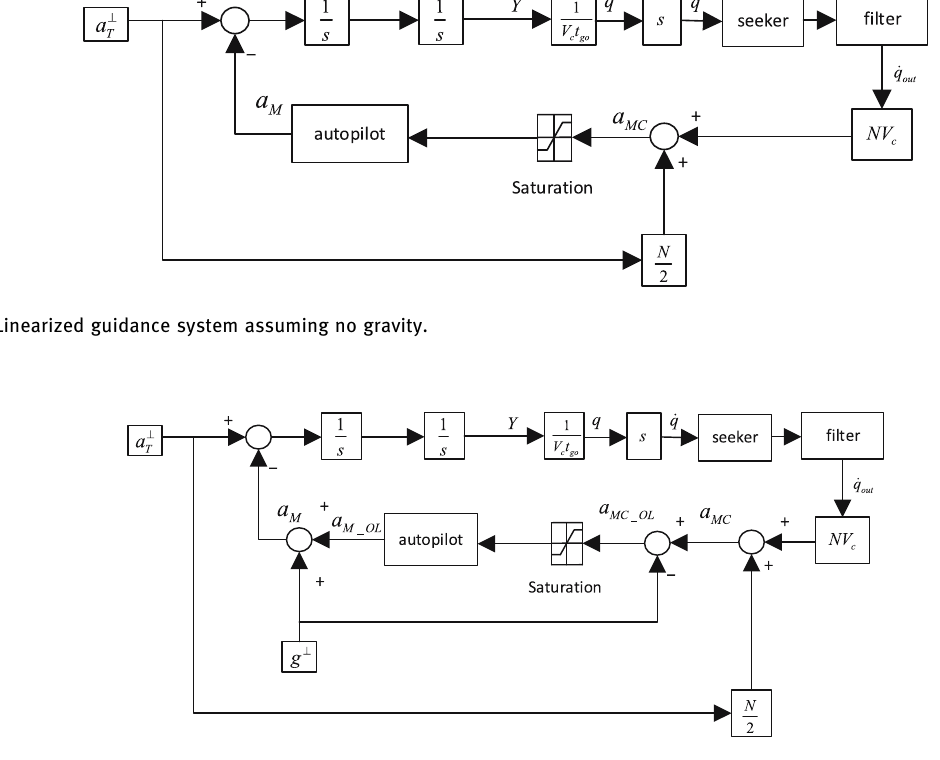
Figure 16: Linearized guidance system considering